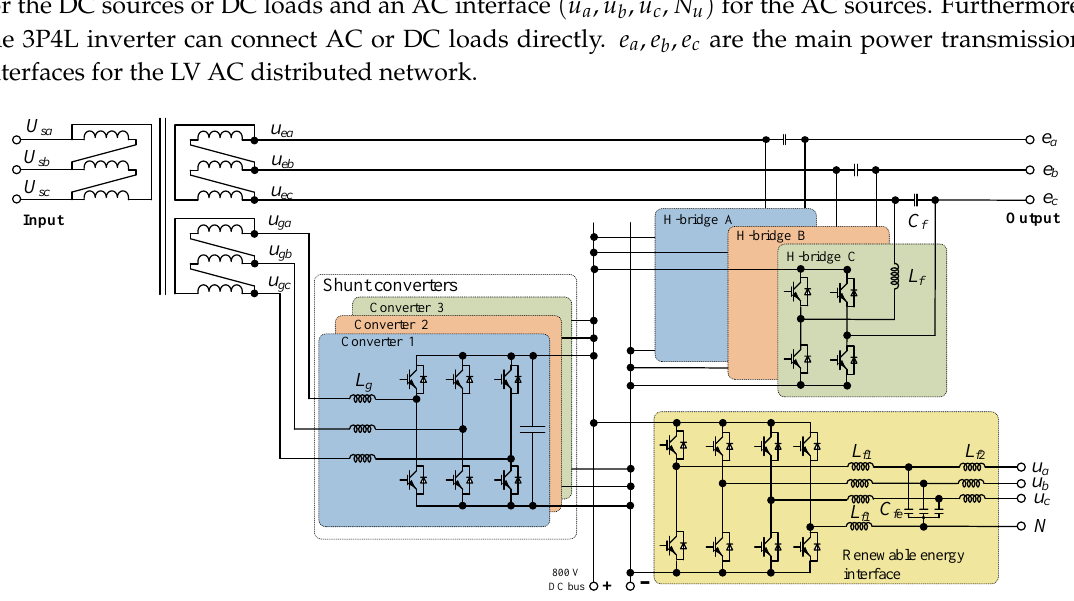
Figure 1. Topology of the proposed multi-converter parallel-based